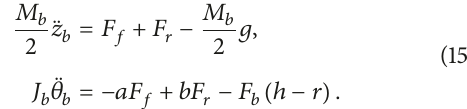
𝑟 is the effective wheel rolling radius.